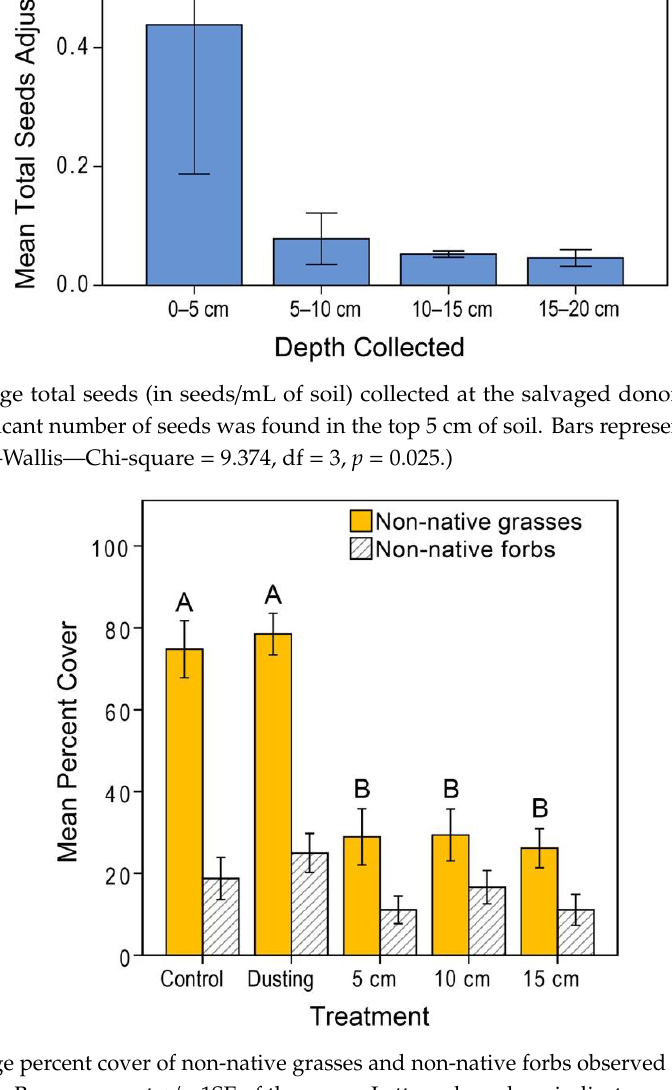
Figure 4. Average percent cover of non-native grasses and non-native forbs observed in salvaged plots in February 2016. Bars represent +/ − 1SE of the mean. Letters above bars indicate results from a Tukey post hoc test, in which unique letters indicate significant di ff erences amongst treatment groups. Letters were not used to signify di ff erences in non-native forb data, because no significant e ff ects were found between any treatment groups. (ANOVA—non-native grasses: F 4,30 = 24.598, p > 0.001; non-native forbs: F 4,30 = 2.589, p = 0.118).